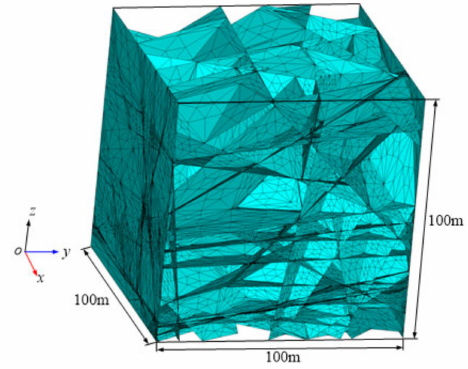
Figure 12. Mesh of 3D DFN.